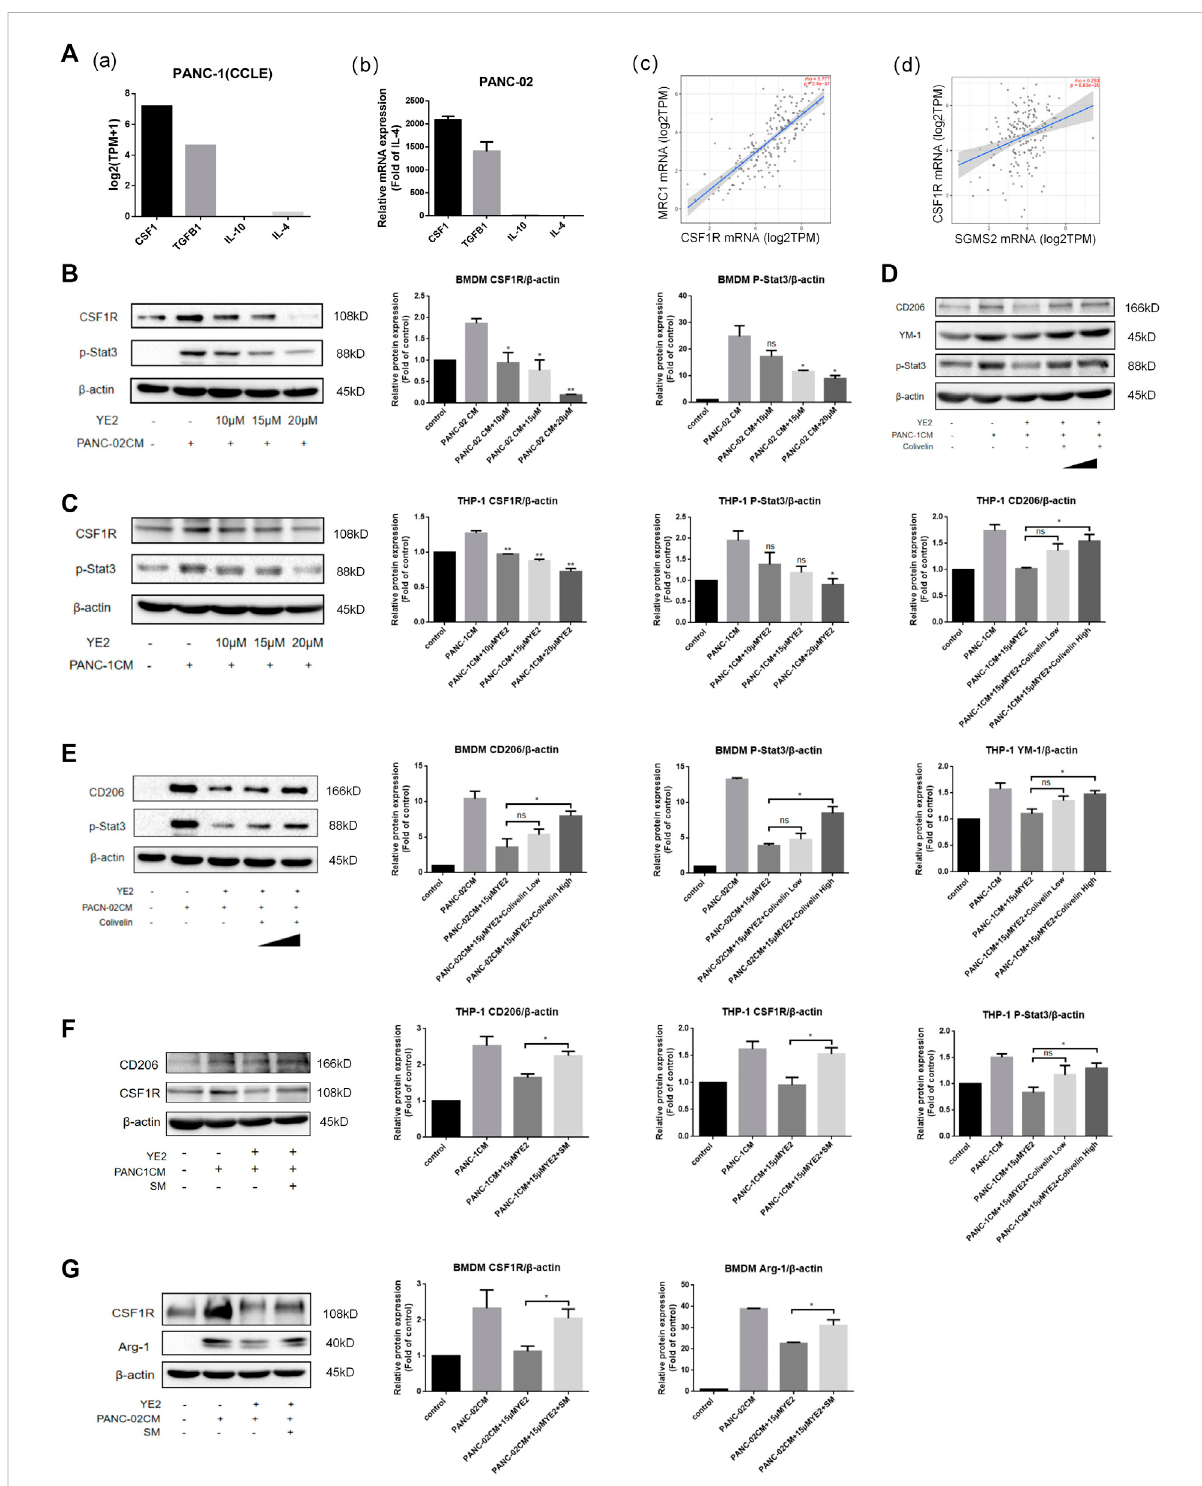
FIGURE 7 The mechanism of SMS2 inhibitors in inhibiting PANC-CM-induced M2 polarization. (A) . Gene expression of the cytokine that can induce M2 polarization in PANC-1 (a) was analyzed by CCLE database and was detected by Realtime PCR in PANC-02 (b). The expression of MRC1 is positivelycorrelatedwithCSF1R(c).TheexpressionofCSF1RispositivelycorrelatedwithSMS2inpancreaticcancer(d).Immunoblottingwasusedto detect the expression of CSF1R and downstream proteins in BMDM (B) and THP-1 (C) after PDAC-CM stimulation for 48 h with or without YE2. Immunoblotting was used to detect the expression of CD206 and p-Stat3 in BMDM (E) and THP-1 (D) after rescue of p-Stat3 with Colivelin. ImmunoblottingwasusedtodetecttheexpressionofCSF1RandM2marker(Arg-1orCD206)aftersupplementofexogenoussphingomyelin(SM)in BMDM (G) and THP-1 (F) . The densitometry analysis data of BMDM (B,E and G) and THP-1 (C,D and F) was showed. * p < 0.05; ** p < 0.01; *** p <